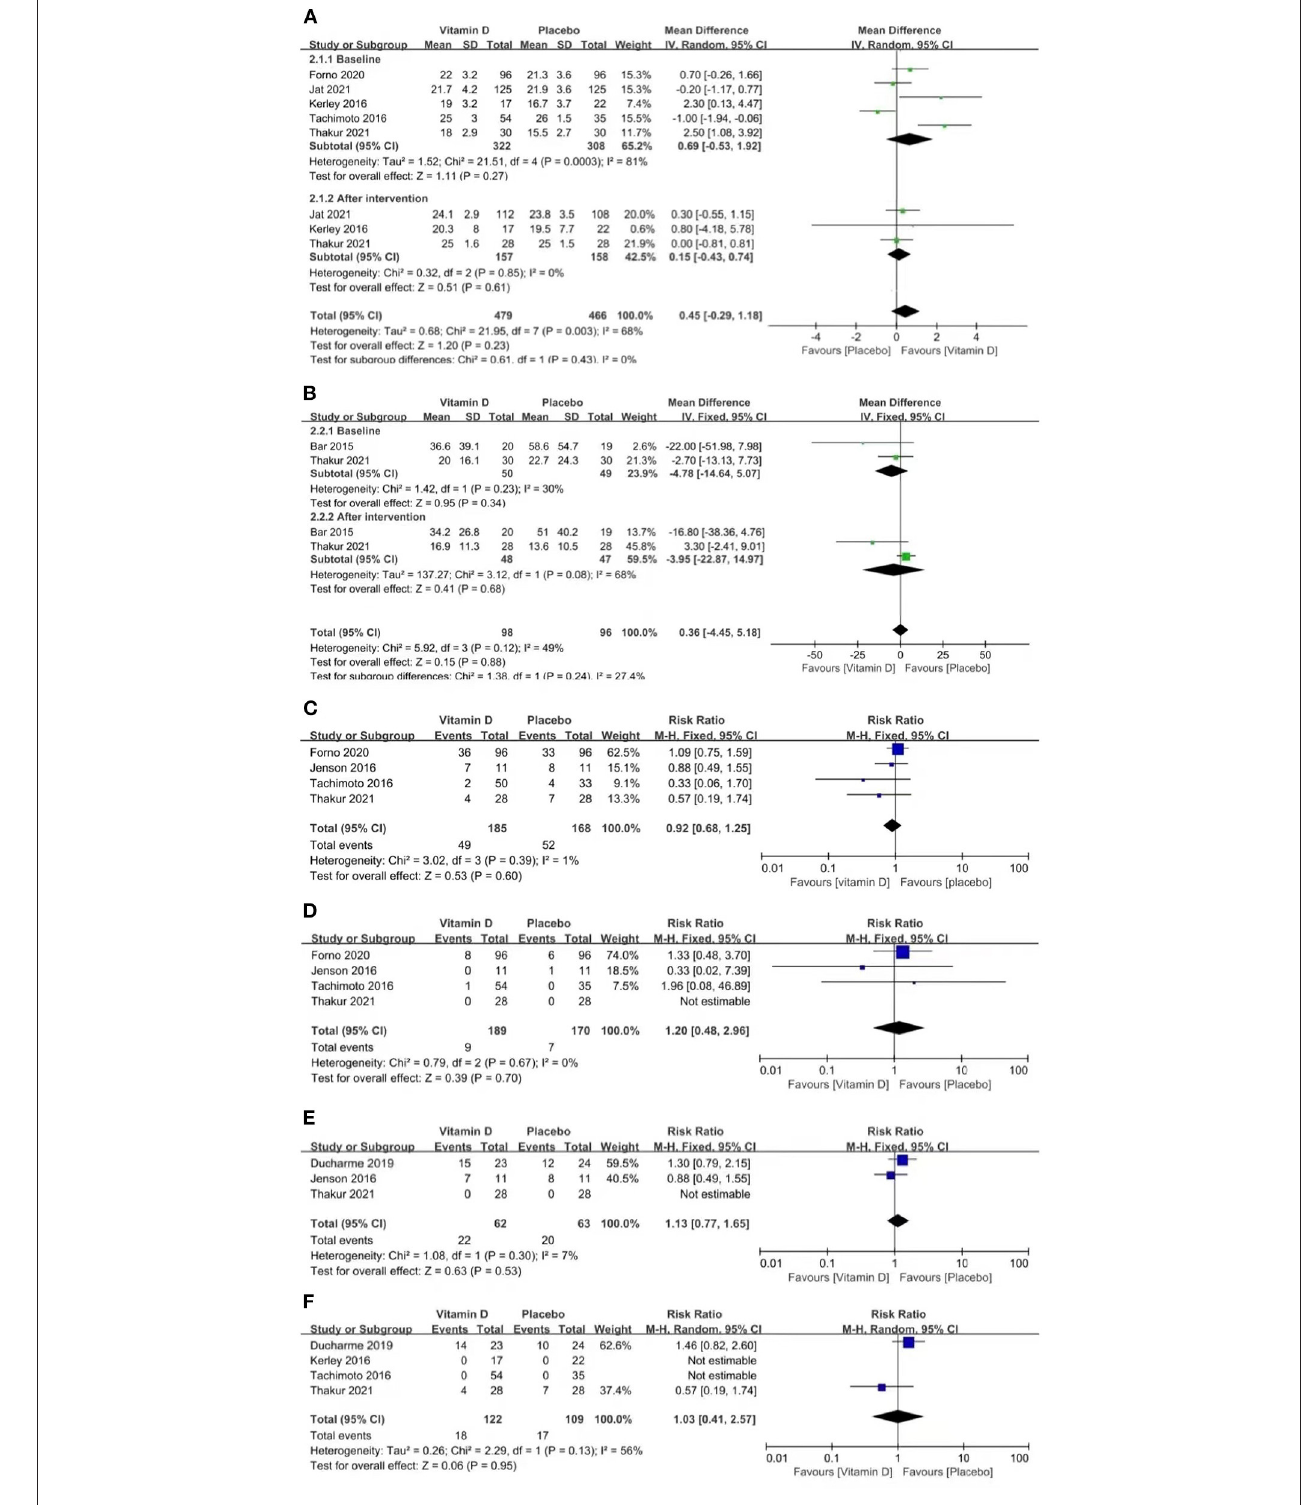
FIGURE 3 | Forest plots of MD of CACT scores (A) and FeNO (B) , and RR of asthma exacerbation (C) , hospitalizations for asthma exacerbation (D) , acute care visits (E), and steroid use (F) associated with vitamin D vs. placebo.